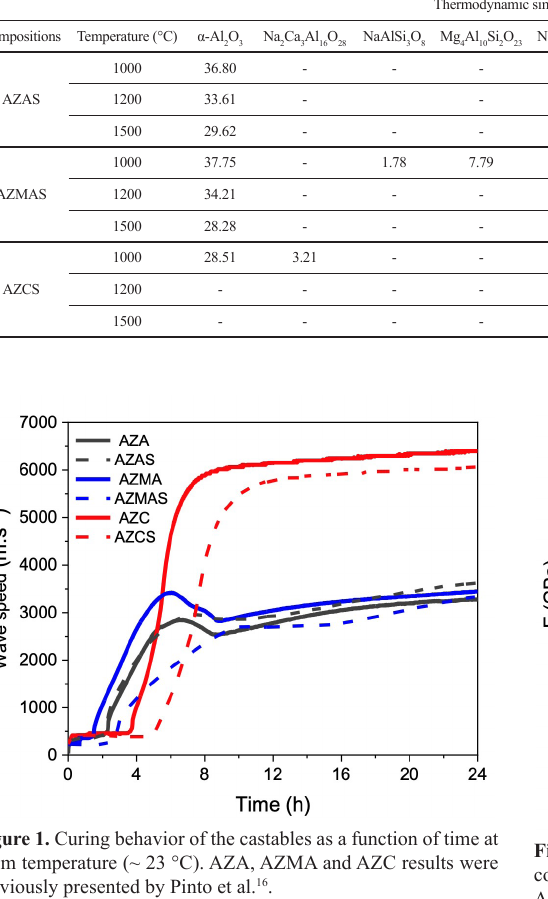
Table 5. Predicted phases (wt%, obtained via thermodynamic simulations) generated in the matrix composition of the designed castables. Thermodynamic